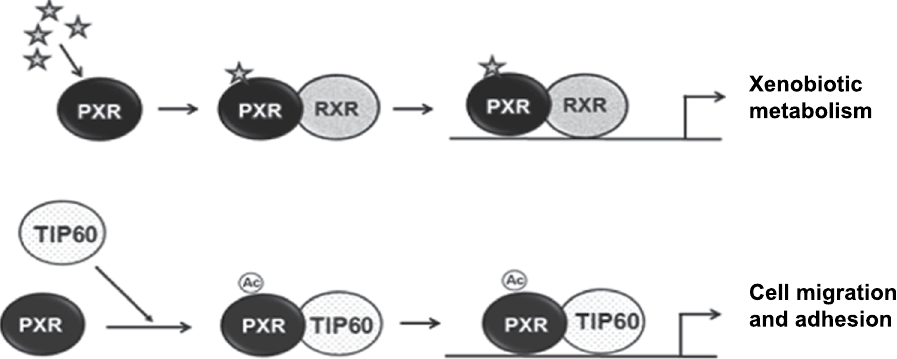
Figure 8. Model depicting selective interaction of unliganded PXR with TIP60. In general, PXR gets activated in presence of its ligand and forms a heterodimeric complex with its partner RXR and binds to the promoter of its target genes to induce their transactivation. This model proposes that under anonymous conditions TIP60 may induce the intranuclear reorganization of unliganded PXR and form a complex. Together, the novel complex of TIP60 & PXR promotes cell migration & adhesion via regulating the pathways that remains to be determined. Unliganded PXR in complex with TIP60 may perform alternative physiological functions within the cell other than the recognized ligand-dependent functions suggesting that the combinatorial effect of the cellular levels of these important coregulatory proteins along with cellular microenvironment may regulate their behavior and functional outcome in a context-dependent manner. Star in the figure depicts PXR ligand and (Ac) denotes acetylation